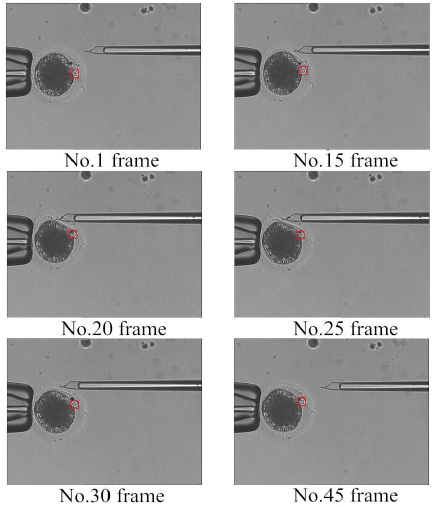
Figure 10. Detection results of oocyte rotation.